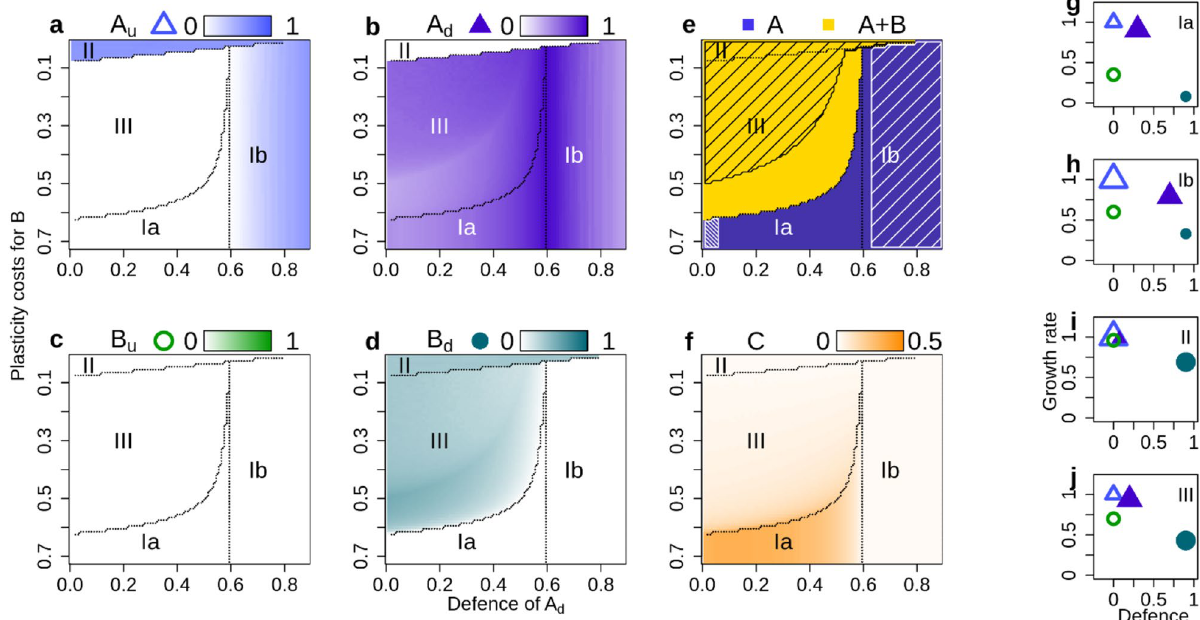
Figure 2. Biomasses, coexistence and trait space for scenario parallel 0 . Biomasses of the four autotrophic phenotypes ( a – d ), their coexistence patterns ( e ), the consumer biomass ( f ) and the autotrophs’ trait values ( g – j ) (higher biomasses are shown by darker colours). Lines in ( a – f ) separate the regions I–III of different coexistence patterns. Note that in ( a – f) , the y-axis is reversed to show increasing fitness along all axes. An exemplary trait combination for every region is shown in ( g –j ) ; larger symbols indicate the surviving phenotypes. Shaded areas in ( e ) depict oscillating systems (quarter-lag predator–prey cycles in dense shading, antiphase cycles in loose